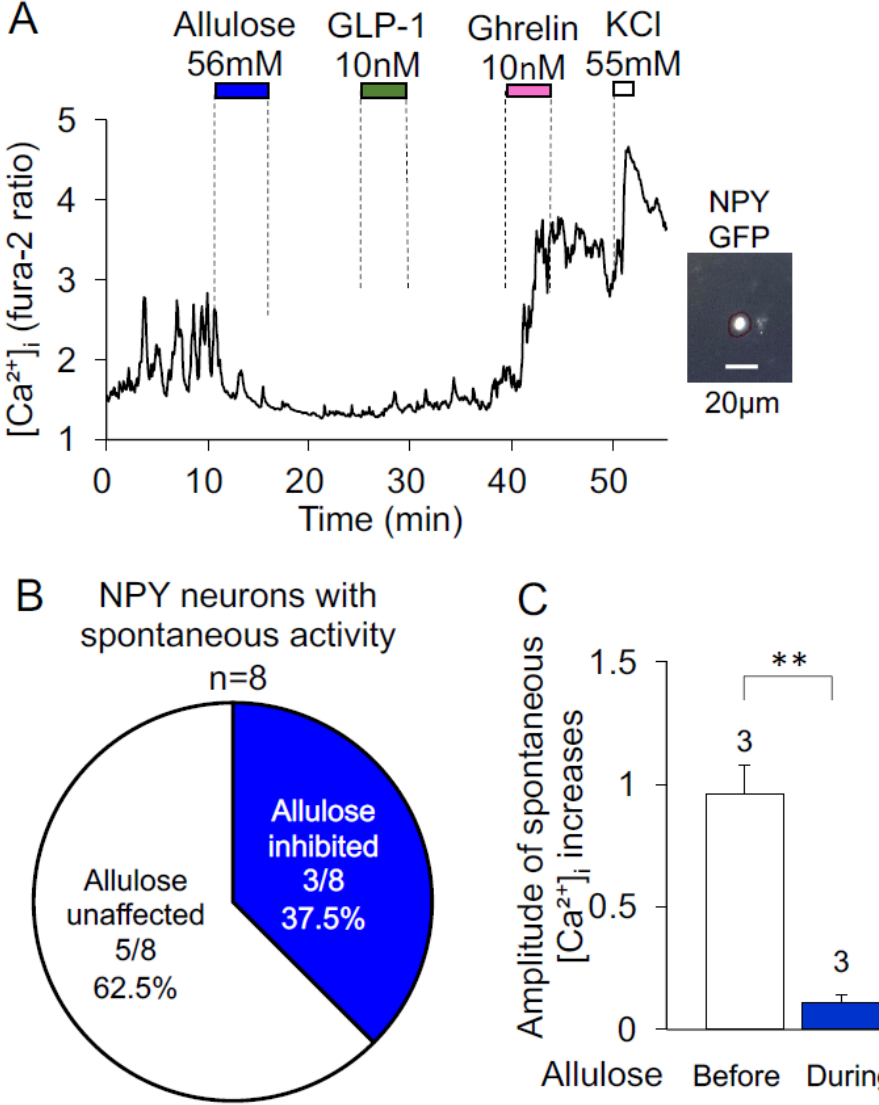
Figure 3. D -allulose effect on spontaneous [Ca 2+ ] i increases in NPY neurons isolated from